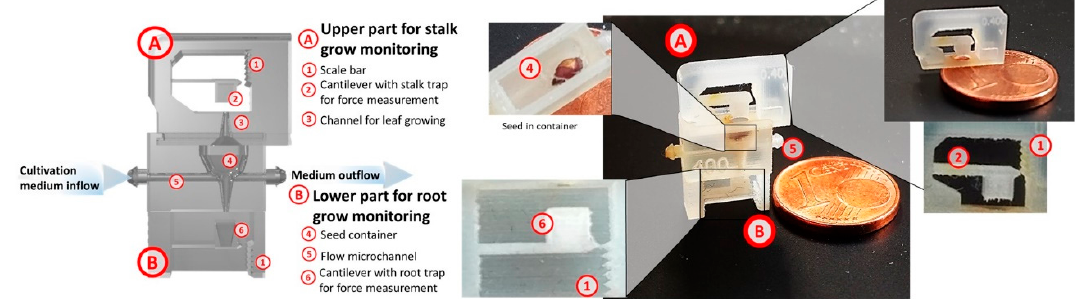
Figure 1. 3D printed micropot-computer design (left image) with described main components and a physical realization (right).